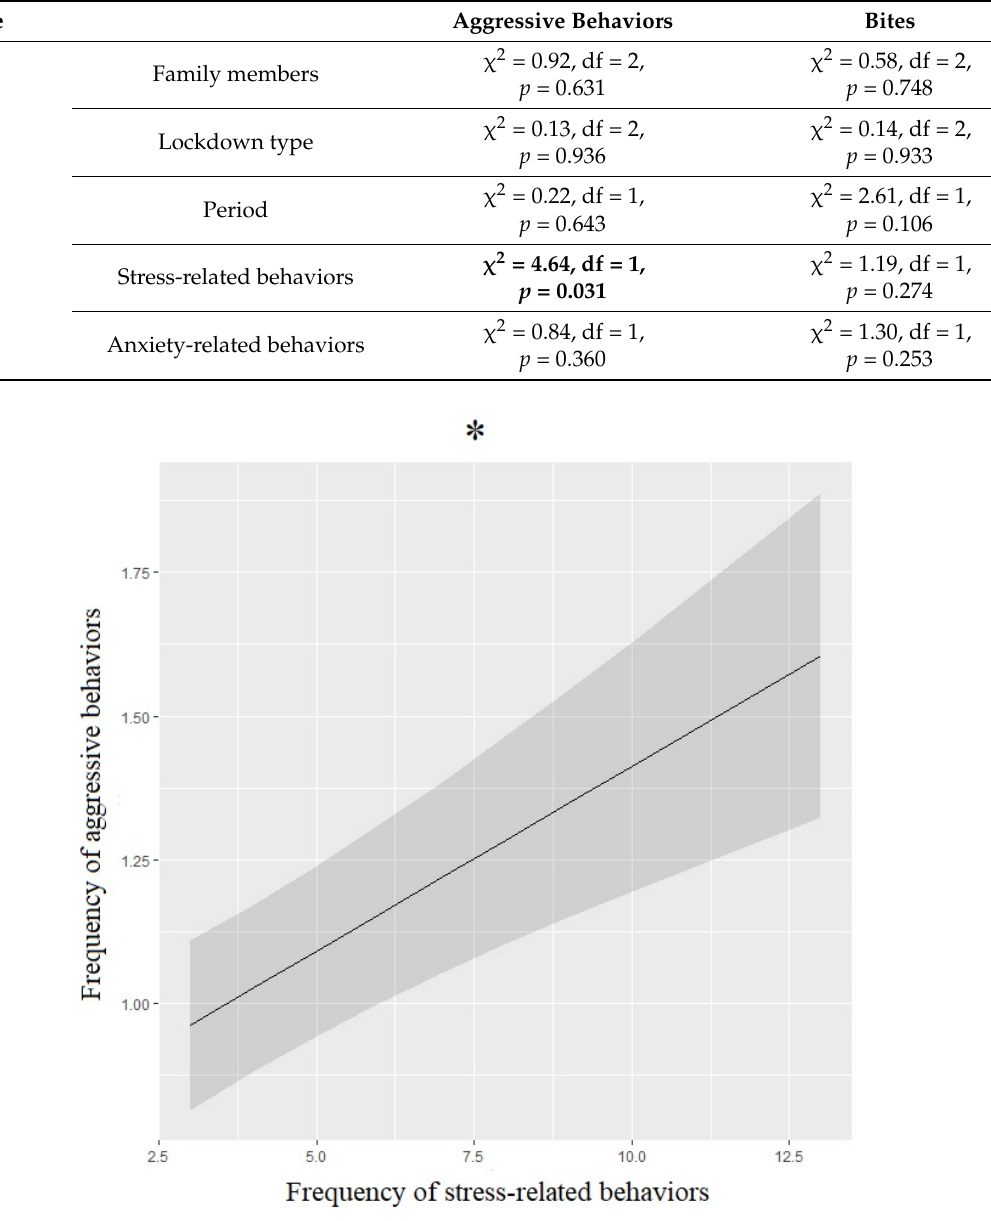
Figure 3. Means and 95% confidence intervals of dogs’ aggressive behaviors’ frequency depending on the frequency of stress-related behaviors extracted from ordinal logistic regression. *: p < 0.05, Wald chi-squared test. Table 4. Statistical outputs from ordinal logistic regressions for